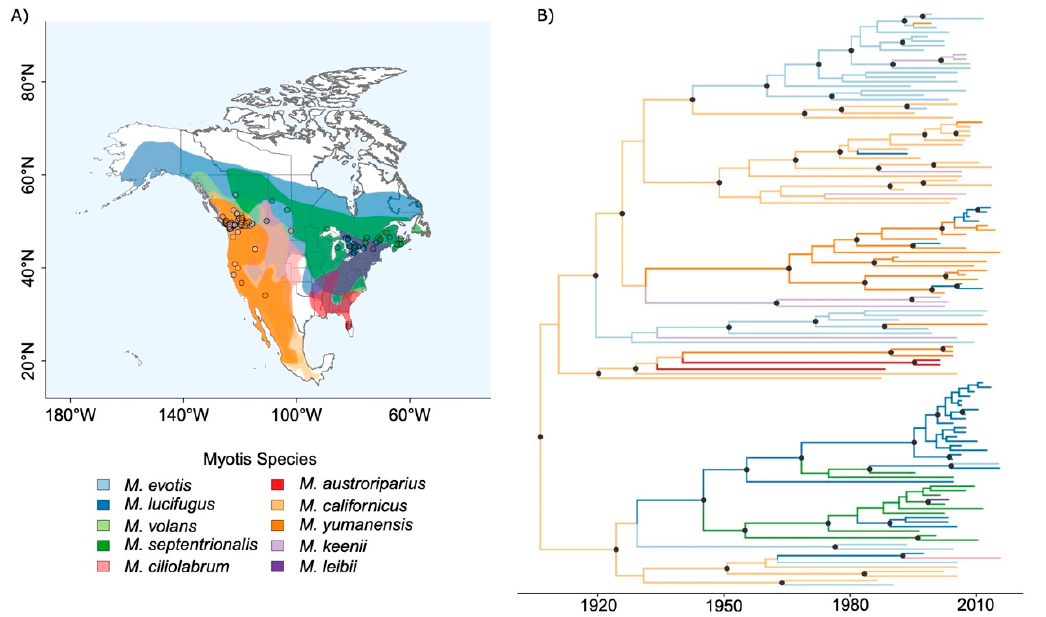
Figure 1. Location and host species origins of samples used in this study ( A ) Map of Myotis species sample locations and host ranges, colours indicate host species range and points show the location of collection of a Myotis bat infected with rabies virus (RABV). ( B ) Maximum Clade Credibility tree of Myotis bat RABV nucleoprotein gene sequences. Branches are coloured by associated host species as specified in the map legend. Node circles indicate nodes with posterior support >0.9.